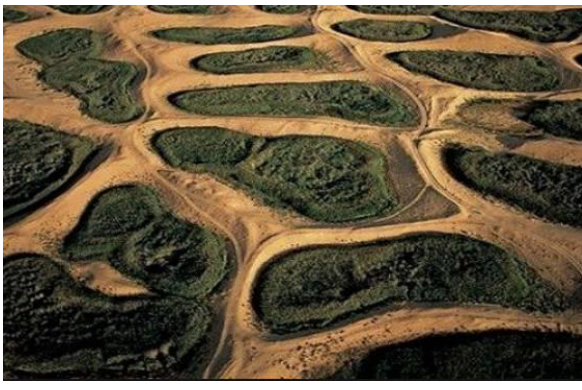
Figure 6. ‘Ghitanes ’ cultivation technique, https://dzcharikati.net/el-oued-la-phoeniciculture-dans-le-ghout- un-patrimoine-agricole-et-touristique/, accesses on 20/01/2020.